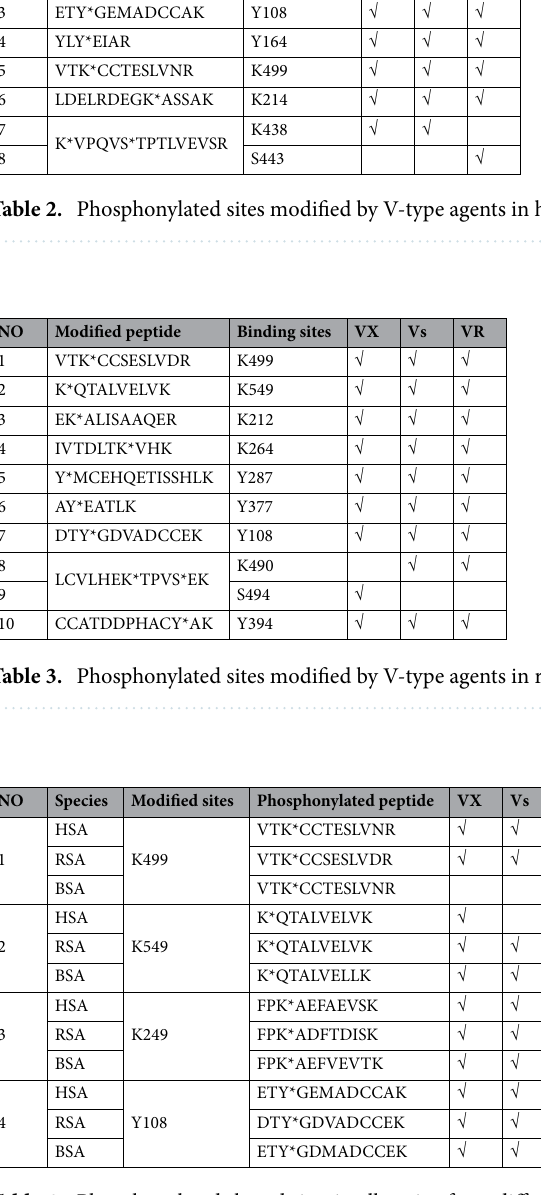
Table 4. Phosphonylated shared sites in albumins from different species after V-type OPNAs exposure.